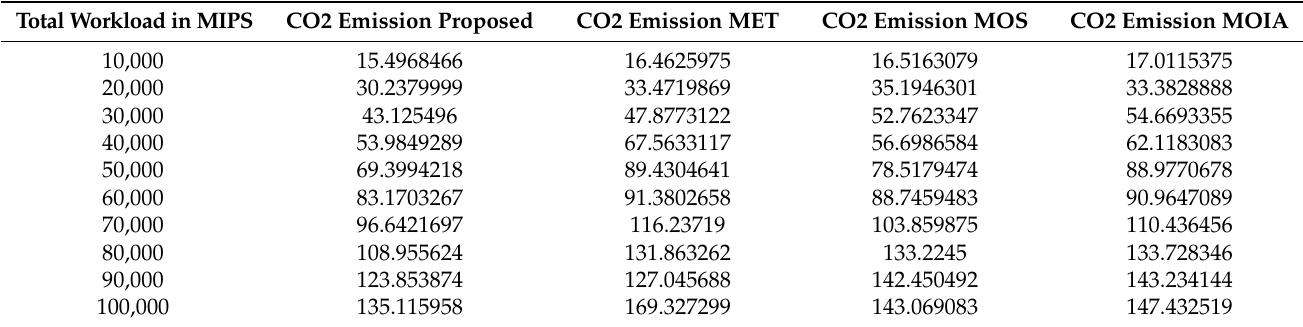
Table 4. CO2 emissions of proposed vs. state of the art techniques.